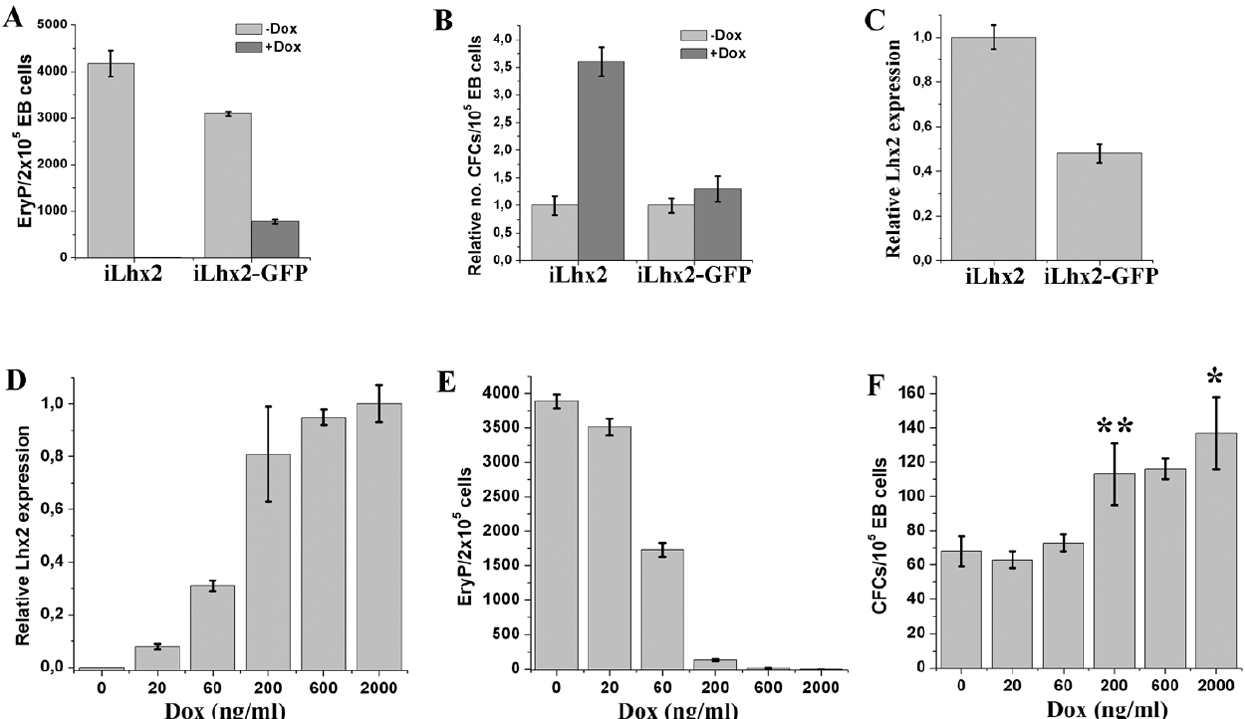
Figure 2. Lhx2 expression in clonal assays inhibits proliferation of EryP precursor cells and increase the frequency of definitive CFCs. A. Frequency of EryP precursor cells in day 6 EB cells generated from the iLhx2 or iLhx2-GFP ES cell lines if clonal assays were performed in the absence ( 2 Dox) or presence ( + Dox) of dox B. Relative frequency of definitive CFCs in day 6 EB cells generated from the iLhx2 or iLhx2-GFP ES cell lines if the clonal assays were performed in the absence ( 2 Dox) or presence ( + Dox) of dox. C. Relative expression of Lhx2 analysed by real-time PCR comparing iLhx2 and iLhx2-GFP ES cells cultured in the presence of dox for 2 days. D. Relative Lhx2 expression analysed by real-time PCR in iLhx2 ES cells cultured for 2 days in the presence of dox at the indicated concentrations. Maximal Lhx2 expression is reproducibly achieved in the presence of 2 m g/ml of dox which is arbitrarily set as 1. E. Frequency of EryP precursor cells in clonal assays of day 6 EBs performed in the presence of dox at the indicated concentrations. F. Frequency of definitive CFCs in clonal assays of day 6 EBs performed in the presence of dox at the indicated concentrations. *p , 0,01 compared to no dox addition (0 ng/ml). **p , 0,02 compared to no dox addition.